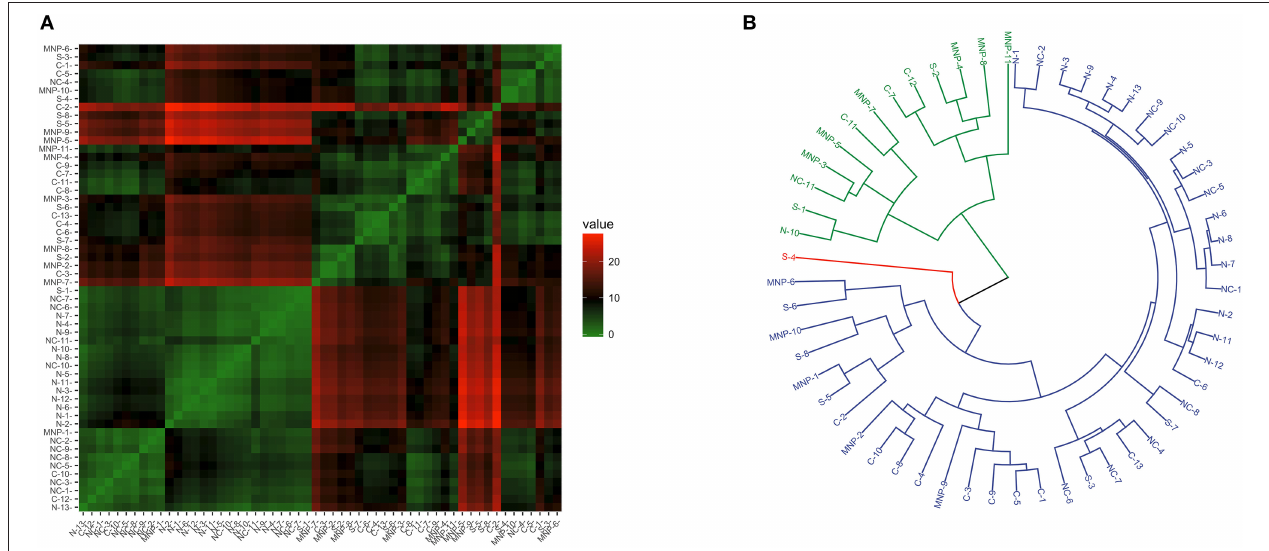
FIGURE 3 | Similarity of NK and CD 8 + T cell transcription ( Ly49 , perforin , Granzyme B, STAT-1 , Tbx21 , and Eomes ) in blood of California sea lions sampled at different regions. (A) Heatmap shows similarity clustering of the gene profiles. Green indicates low dissimilarity and red indicates high dissimilarity. (B) Dendrogram of gene transcription profile clustering. The tree was built using an Euclidean algorithm. S, South; C, Central; NC, North-Central (Midriff); N, North; MNP, Mexican North